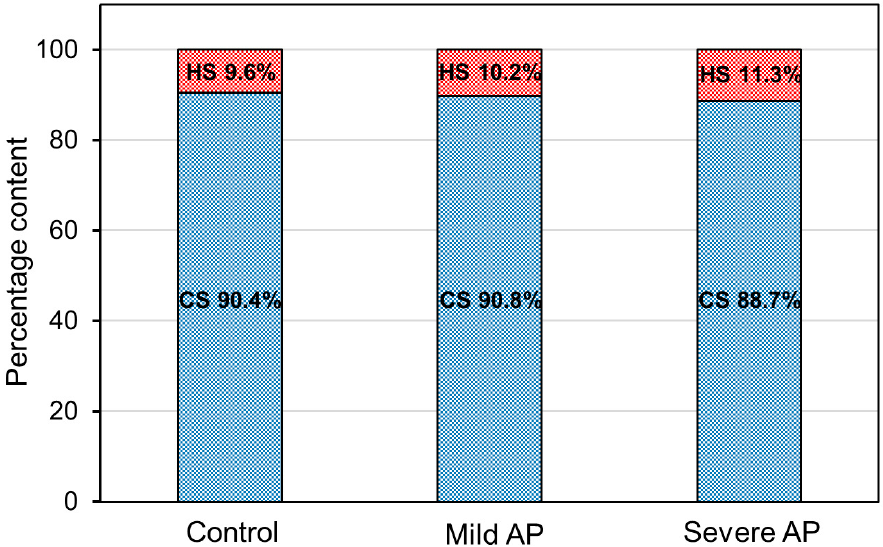
Figure 5. Concentrations of the circulating heparan sulfate (HS) in the healthy controls and the patients with mild or severe acute pancreatitis (AP). HS was identified in the samples of plasma glycosaminoglycans using a combination of electrophoresis on the cellulose acetate and treatment with heparinases I and III. Data are presented as means ± SD. a—differences statistically significant ( p < 0.05) compared to the healthy controls.